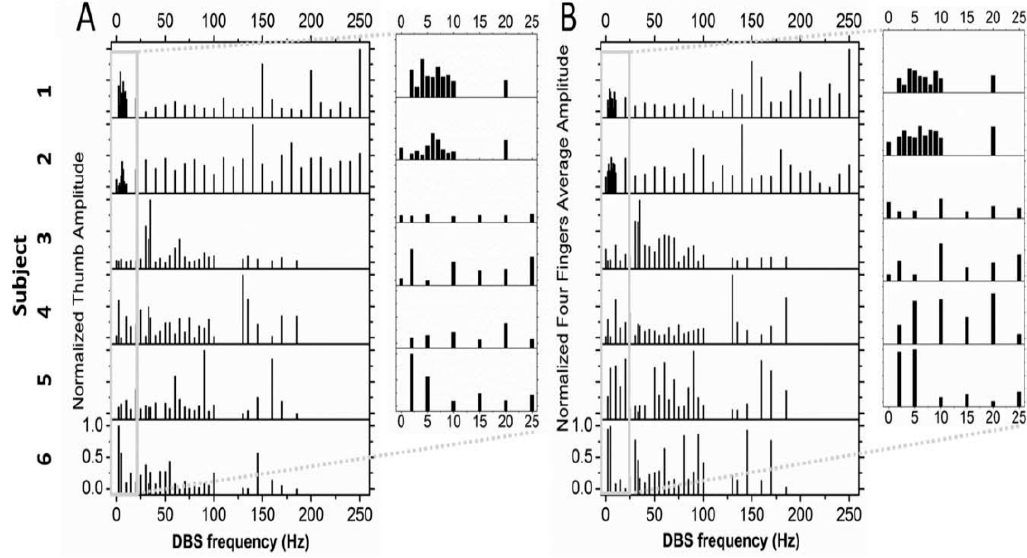
Figure 1. Patients with Parkinson’s disease executed rapid hand opening and closing while wearing a glove that recorded finger and thumb movements. Following an overnight fast, these patients received their first dose of medications used to treat Parkinson’s. Movements of the fingers were separated from those of the thumb. The movement amplitudes were normalized by scaling from 0 to 1 where 1 represents the maximum amplitude. The mean over all the movements was analyzed: ( A ) for the thumb and ( B ) for the fingers (pooled across all the fingers) for each subject. Absence of a column indicates that the associated stimulation frequency was unavailable with the subject’s Implanted Pulse Generator (IPG). Multiple peaks in amplitude movements are found across multiple frequencies, including low frequencies. (Inserts) Amplitudes for the lower range of stimulation frequencies are shown in the expanded window [3].